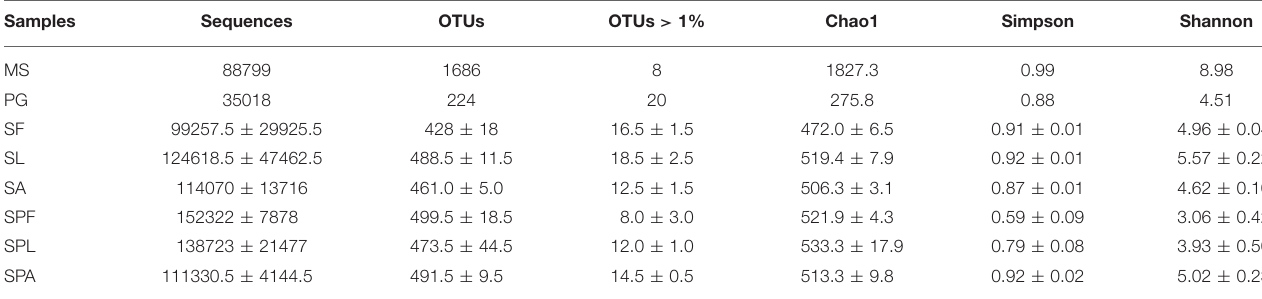
TABLE 1 | Richness and diversity of microbial communities in marine sediment (MS) and phosphogypsum (PG) samples of Sfax (Tunisia), and in the sulfate-reducing enrichment cultures from MS (as inoculum) using sodium sulfate or phosphogypsum (PG) as sulfate source. Samples